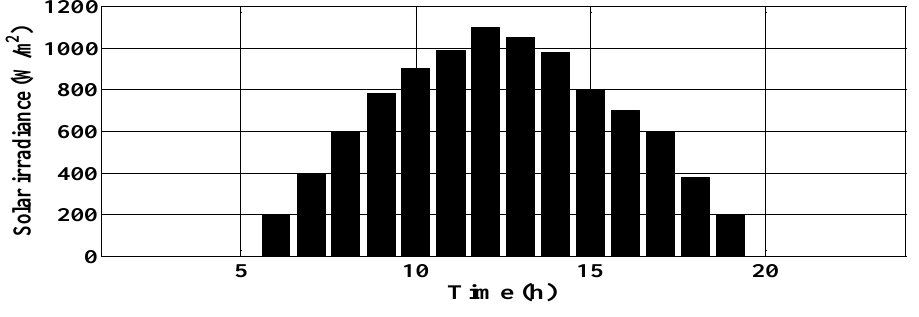
Figure 4. The hourly solar irradiance.